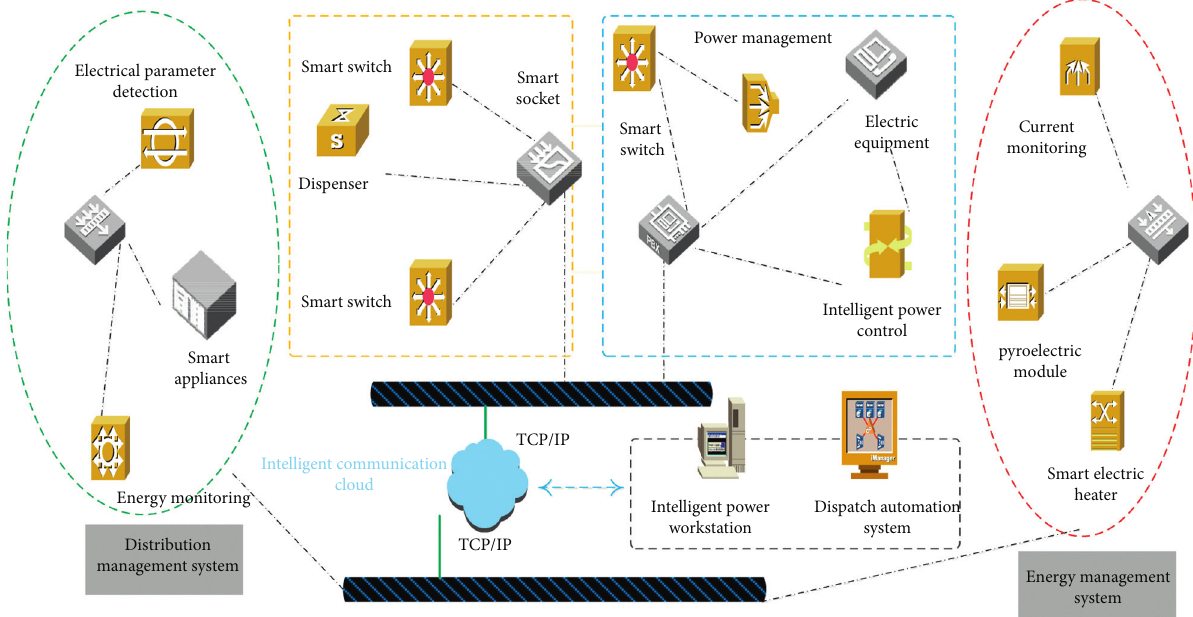
Figure 1: The relationship between the smart grid dispatching system and other systems.